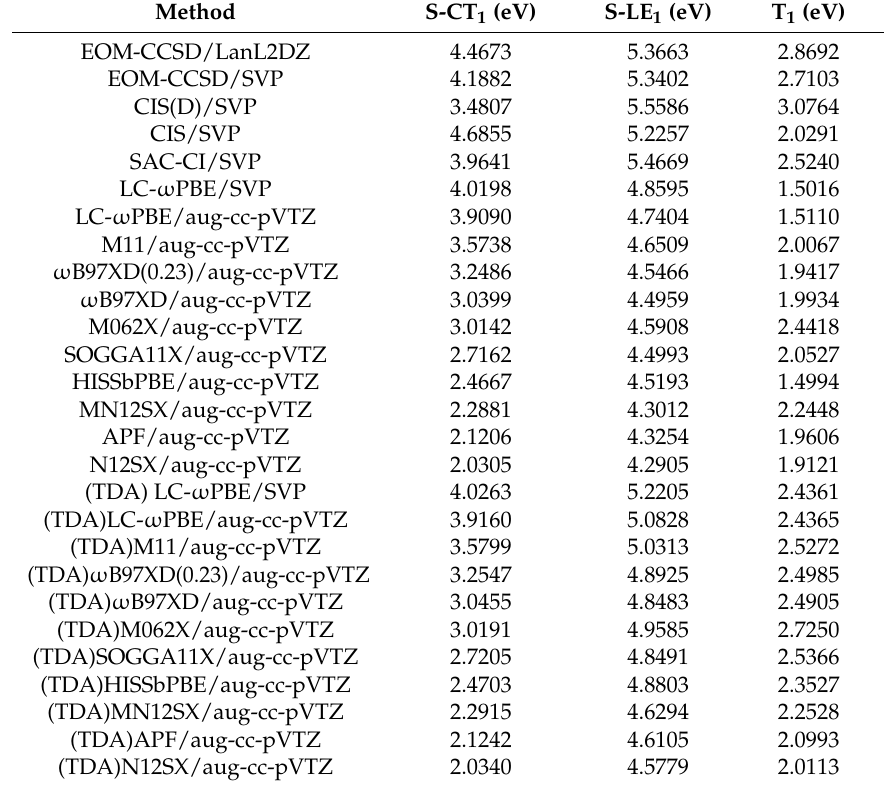
Figure 1. The frontier molecular orbitals involved in charge transfer and local transitions of the benzene-tetracyanoethylene (B-TCNE) complexes via the equation-of-motion coupled-cluster with single and double excitations (EOM-CCSD/SVP) method. The contour threshold of 0.002 a.u. has been applied. Table 3. The calculated vertical electronic excitation energies (eV) of the lowest singlet charge transfer (S-CT 1 ) and locally excited states (S-LE 1 ), as well as the first triplet excited state (T 1 ) for the B-TCNE